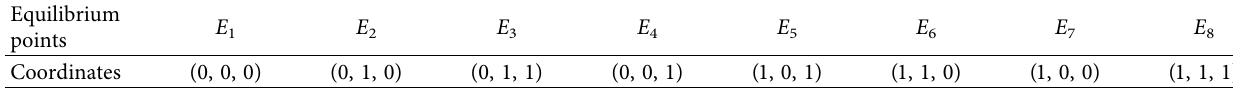
Table 2: Equilibrium points and their coordinates.